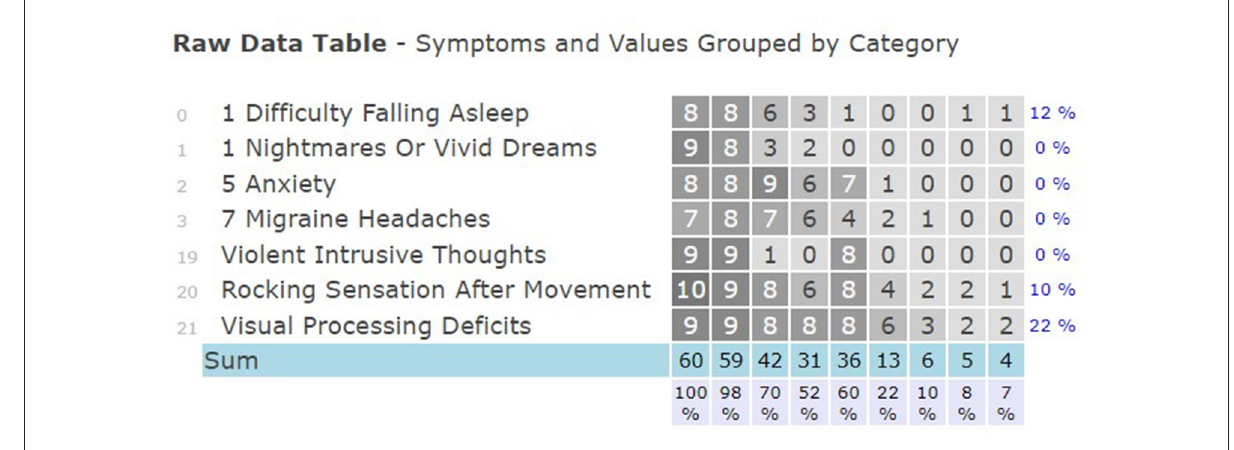
FIGURE3 Rating of symptoms and change